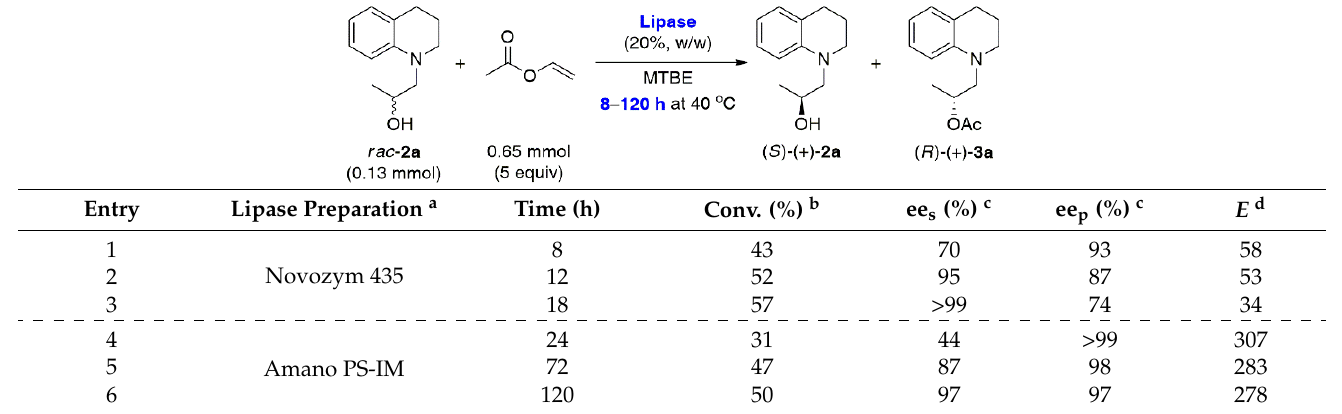
Table 4. Time-course of lipase-catalyzed KR of rac - 2a with vinyl acetate as acyl donor.